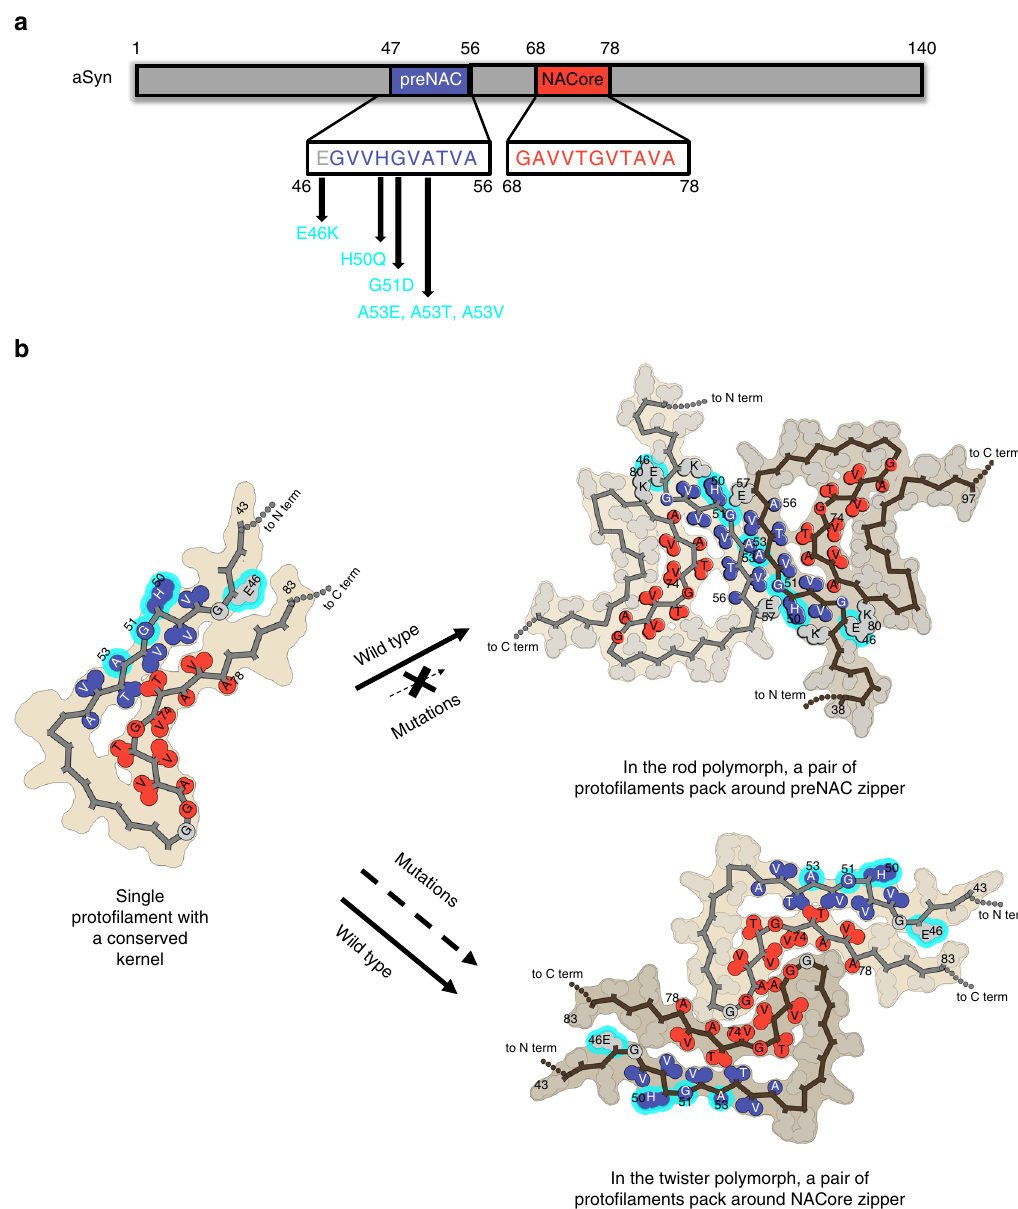
Fig. 4 Morphogenesis of aSyn fi bril polymorphs arising from inter-proto fi lament packing. a Primary sequence of preNAC (blue) and NACore (red) critical for the aggregation of aSyn 1 – 140 and six PD familial mutations (cyan) located near the preNAC region. b Proto fi laments sharing a kernel structure of a bent β -arch assemble into the rod and twister fi bril polymorphs by packing at preNAC and NACore zipper interfaces, respectively. The PD familial mutations (cyan) likely disfavor the rod structure over the twister structures, and alter the polymorphic composition of aSyn fi